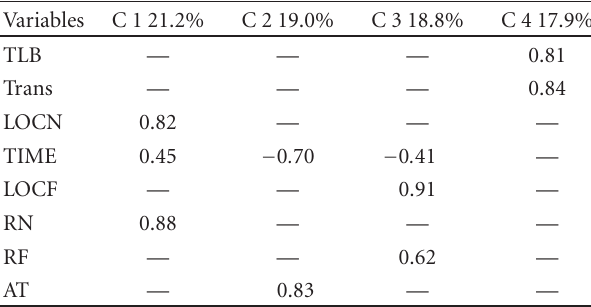
Table 2: Rotated component patterns for experiment 2 (light-dark discrimination and free-exploratory paradigm). TLB = time spent in lit box; Trans = number of transitions; LOCN = number of units entered (locomotion) in the novel area; time = time spent in the novel side; LOCF = number of units entered in the familiar environ- ment; RN = number of rearings in the novel area; RF = the number of rearings in the familiar environment; AT = attempts, taht is, num- ber of approach responses towards the unfamiliar compartment fol- lowed by avoidance reactions. Only component patterns above 0.40 were recorded.